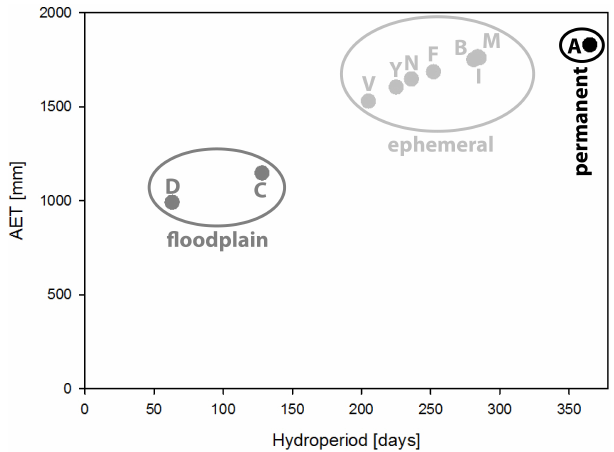
Figure 8. Relationship between total AET [mm] and hydroperiod (annual duration of inundation [days]) for studied water bodies (per- manent, ephemeral,